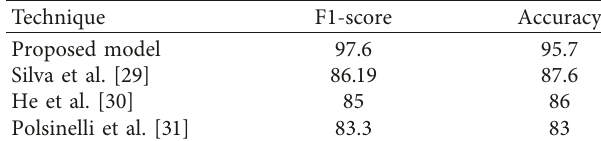
Figure 4: Confusion matrix. Table 7: Comparison with various